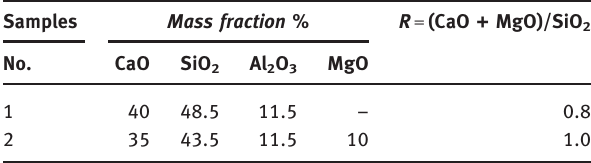
Table 1: Composition of synthetic slags. Samples